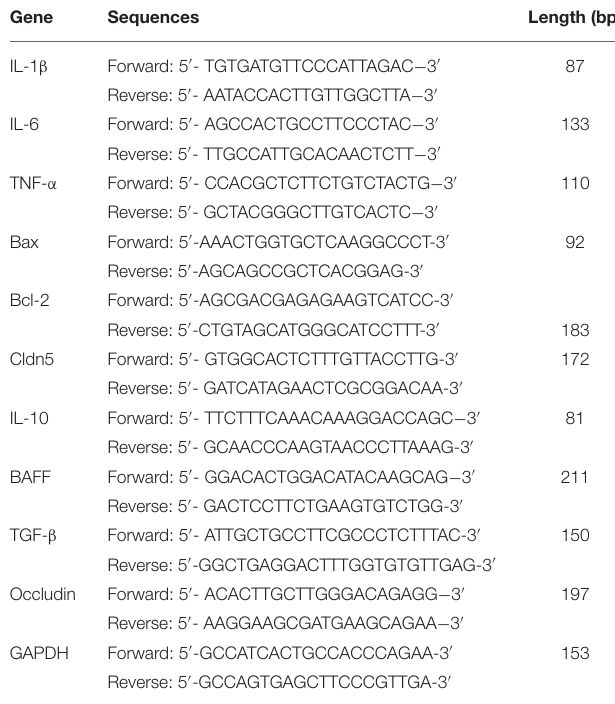
TABLE 1 | Primers for Real-time PCR (mice).